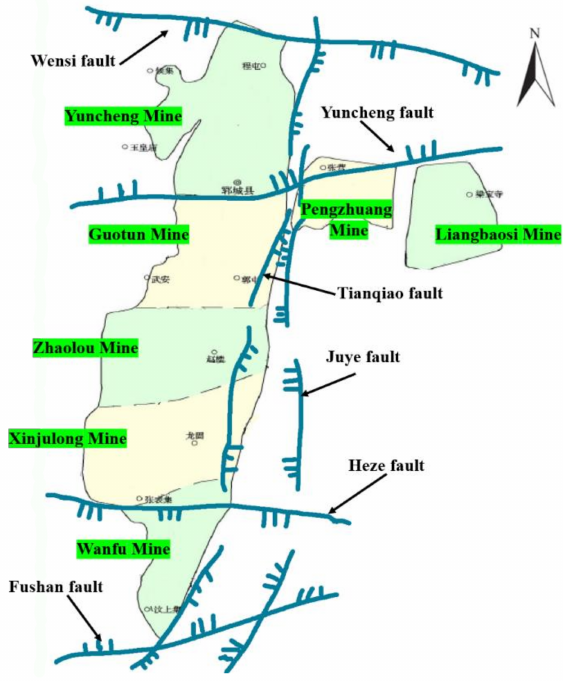
Figure 2. Structural distribution of the Juye mining